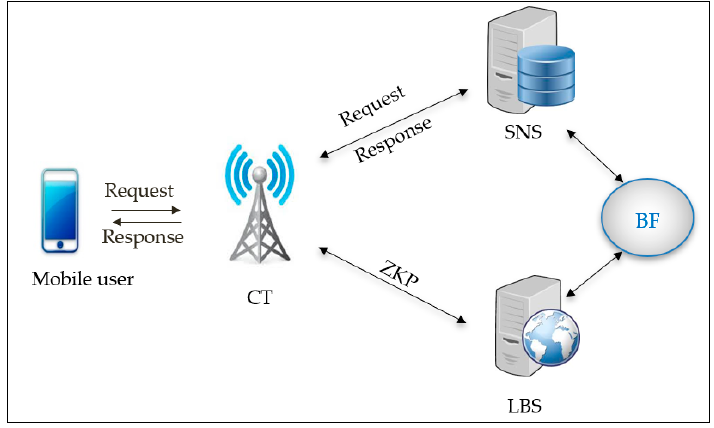
Figure 5. BL0K architecture in LBS.